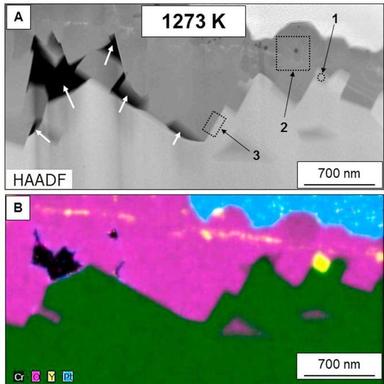
(A) - STEM/HAADF image of a part of a Cr2O3 scale formed after 10 h of oxidation in air at 1273 K; areas selected for subsequent investigations are marked using numbers "1", "2", and "3"; (B) - EDS elemental distribution map of Cr, O, and Y.